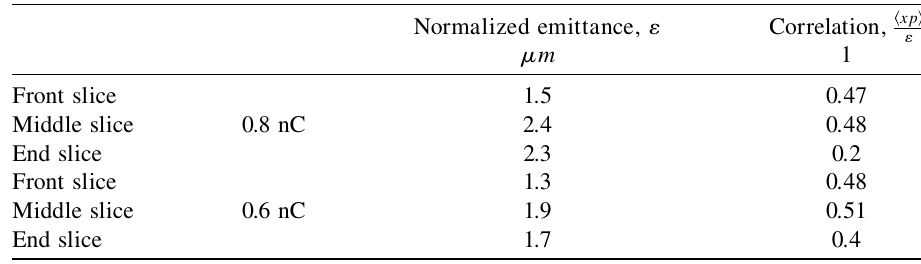
TABLE I. Statistical property of the vertical phase-space density distribution analyzed for the slices shown in Fig. 10. Normalized emittance,